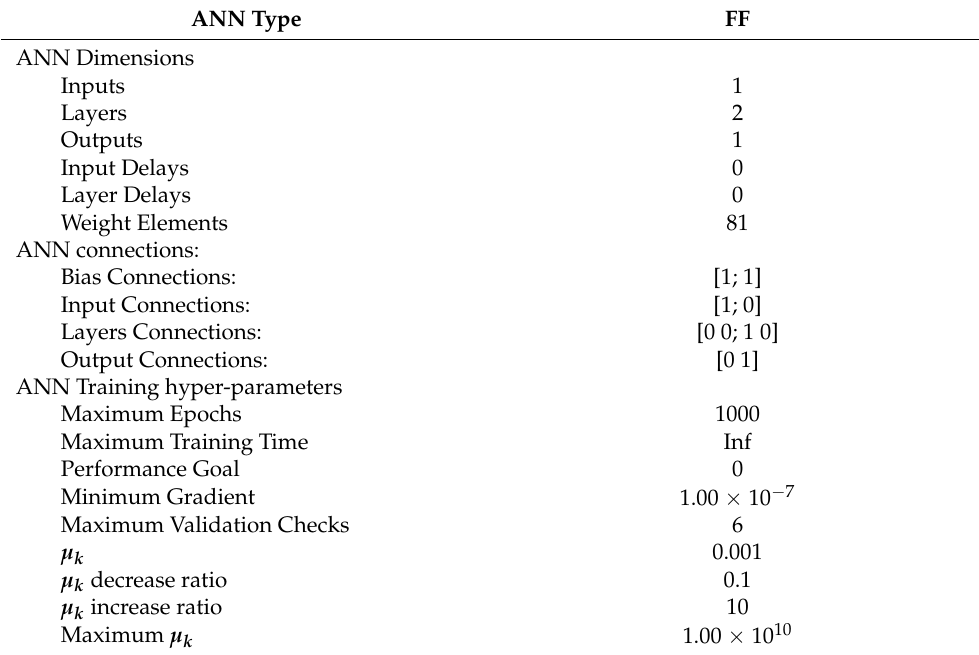
Table 1. Design parameters of the specific type of FF ANN applied, along with the hyper-parameter values related to the training procedure. ANN Type